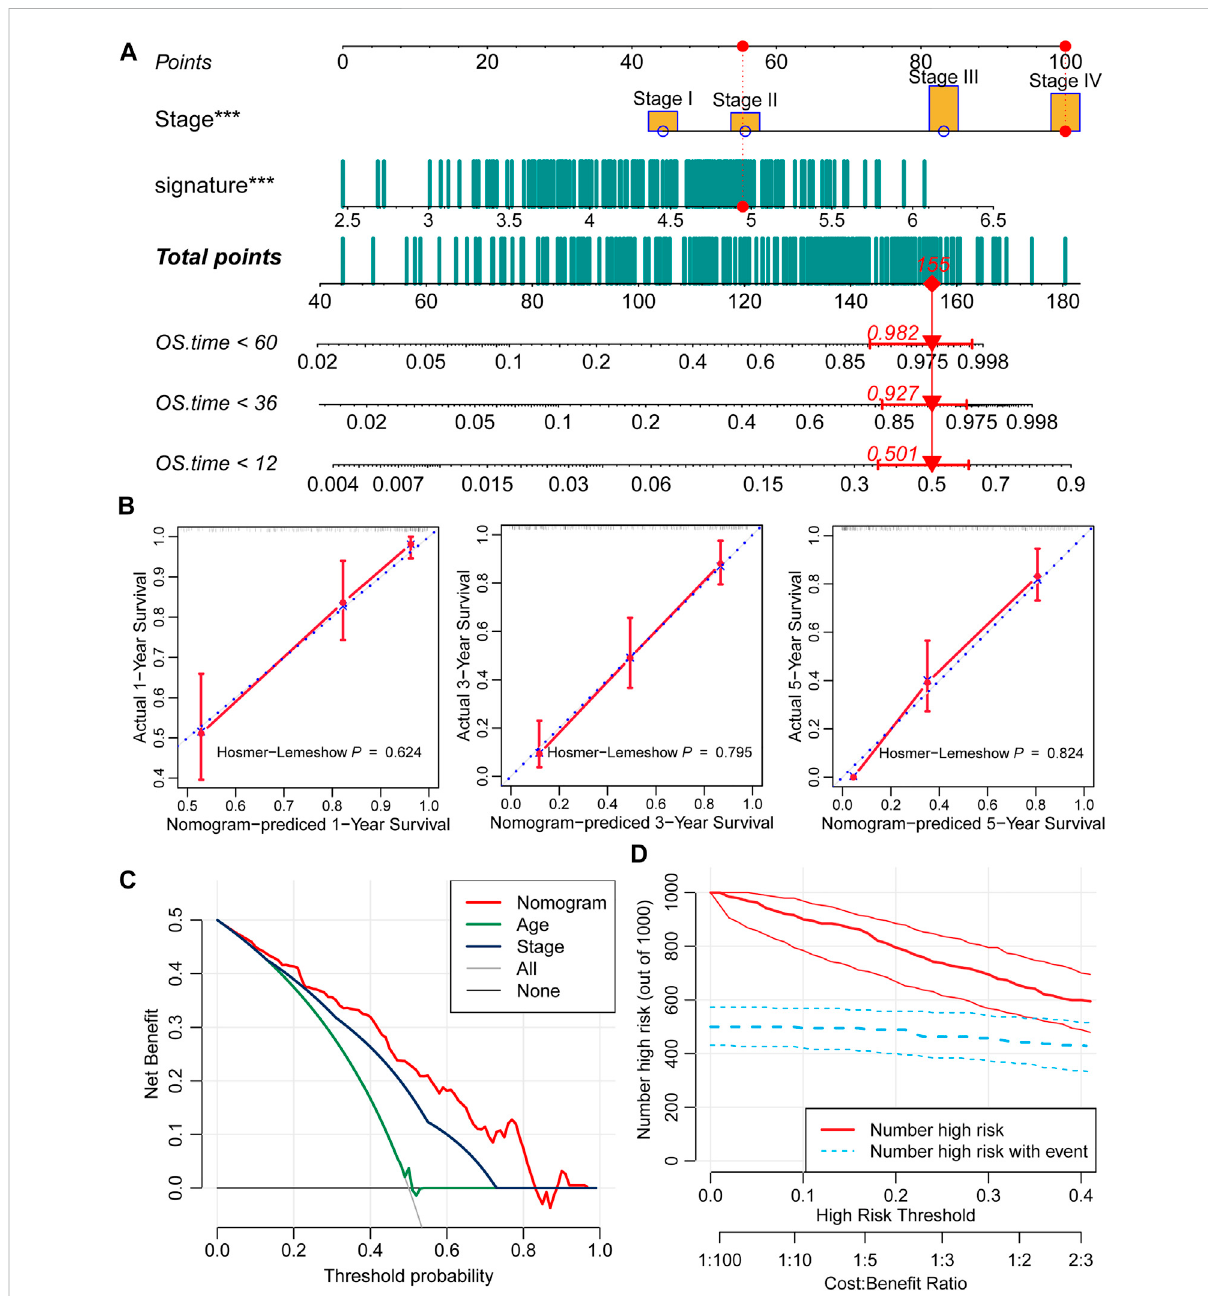
FIGURE 6 Prognostic nomogram based on the nine-consensus prognostic gene signature and clinical features. (A) , Nomogram for predicting the probability of 1-,3-, and 5-years mortality; (B) , Calibration plots ofthe nomogram for predicting theprobabilityof 1-,3-, and 5-years overall survival; (C) , DCA showing the performance of the nomogram and other clinical features for predicting overall survival; (D) , Clinical impact curves of the nomogram for predicting overall